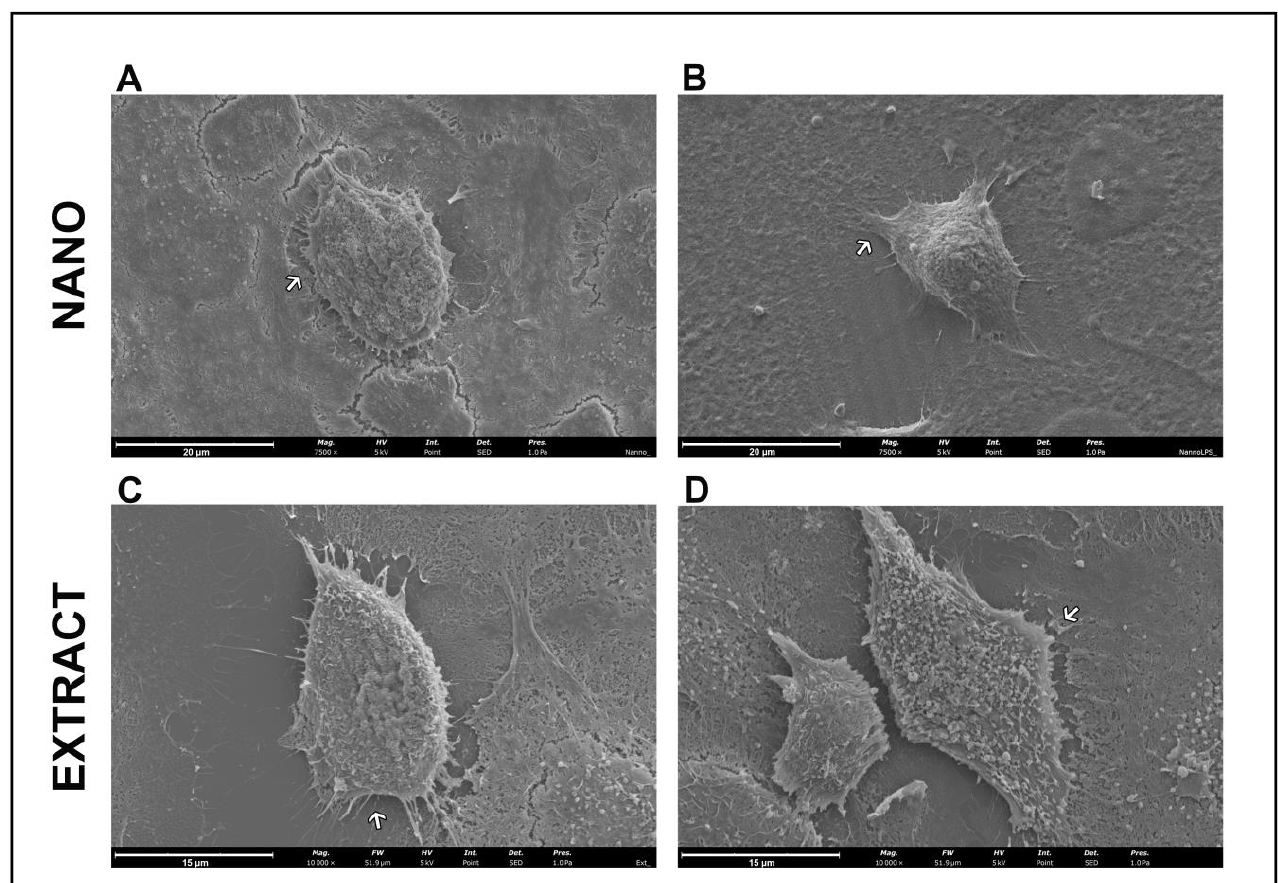
Figure 4. Scanning electron microscopy of HaCaT cells after 24 h of treatment with 5 µ g/mL of nanoLPG ( A , B ) or LPG ( C , D ), in the absence ( A , C ) or presence ( B , D ) of lipopolysaccharides (LPS) at 1 µ g/mL. Arrows indicate extensions on the cell surface.